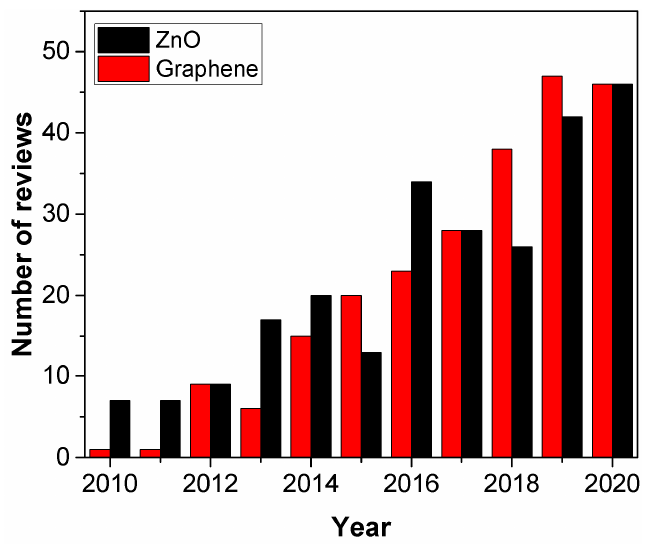
Figure 8. The number of reviews of ZnO and graphene with applications in photocatalysis (source: Scopus).